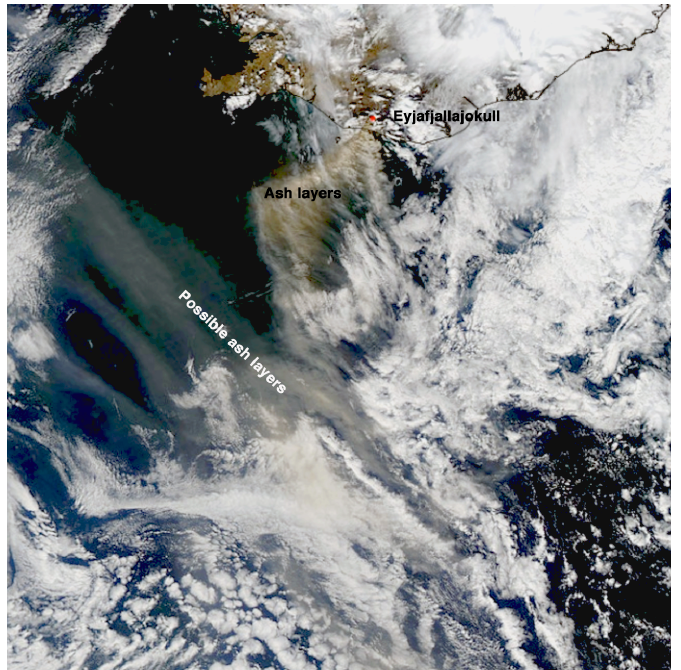
Figure 10. MODIS/Aqua true-colour image acquired at 13:40 UT on 15 May 2010. Possible ash layers are indicated on the